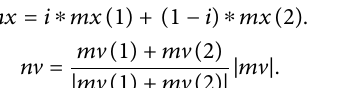
FIGURE 4 | Photovoltaic classic scene set.